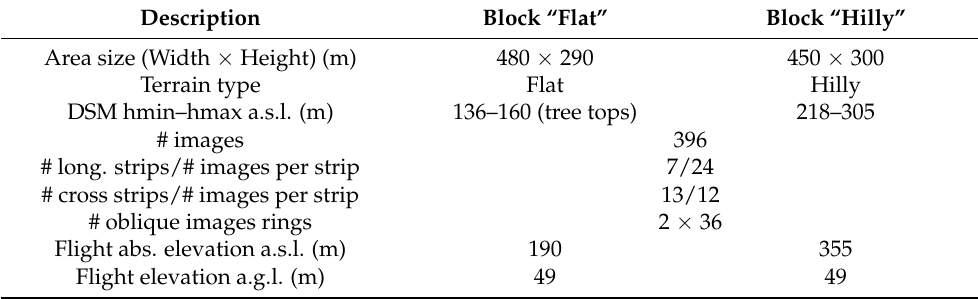
Table 1. Summary of the real blocks’ characteristics used as a basis for simulated data